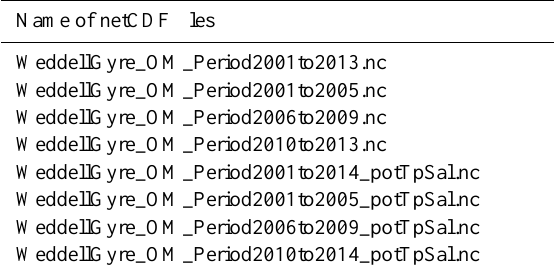
Table A1. List of netCDF filenames where the mapped field vari- ables for the different time-composite periods are